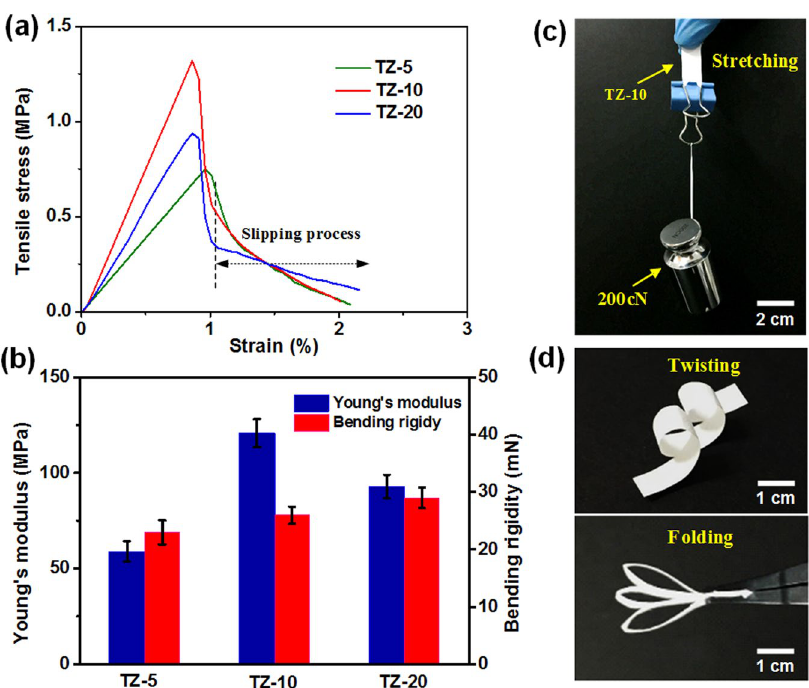
Figure 5. ( a ) Tensile stress-strain curves, and ( b ) Young’s modulus and bending rigidity of TZ-5, TZ-10, and TZ-20 fibrous membranes. ( c , d ) Photographs depicting the softness of TZ-10 fibrous membranes: it can be stretched, twisted and folded without